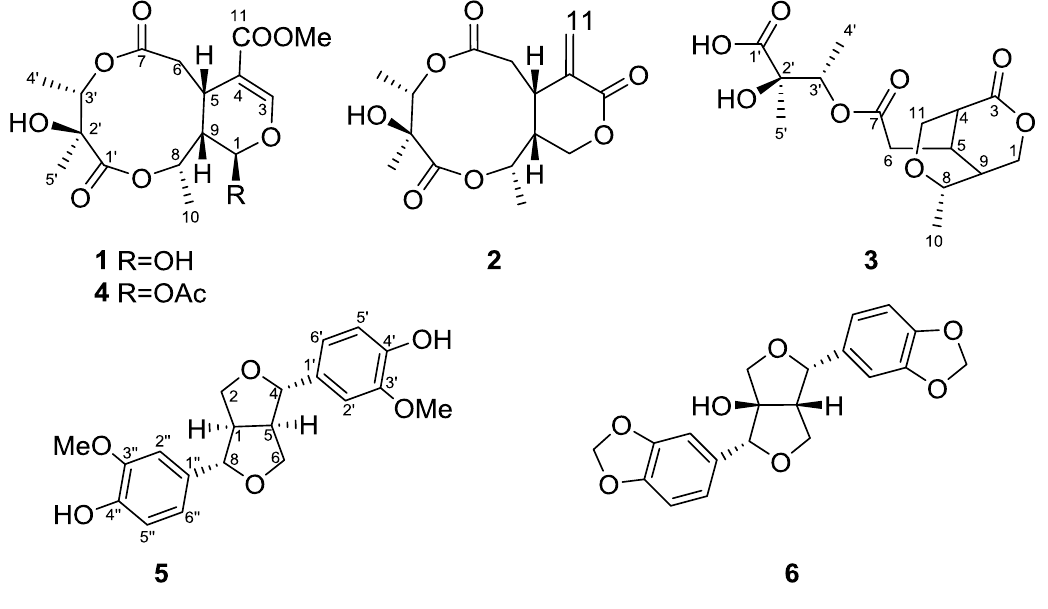
Figure 1. Chemical structures of compounds 1 – 6 .